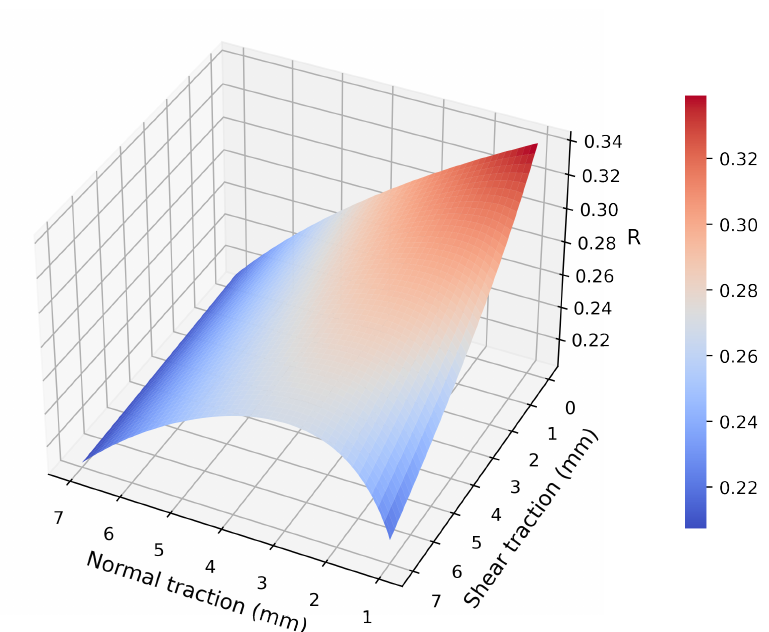
Figure 8. Locations of markers ( R ) maximizing the quality of the markers’ displacement, Q